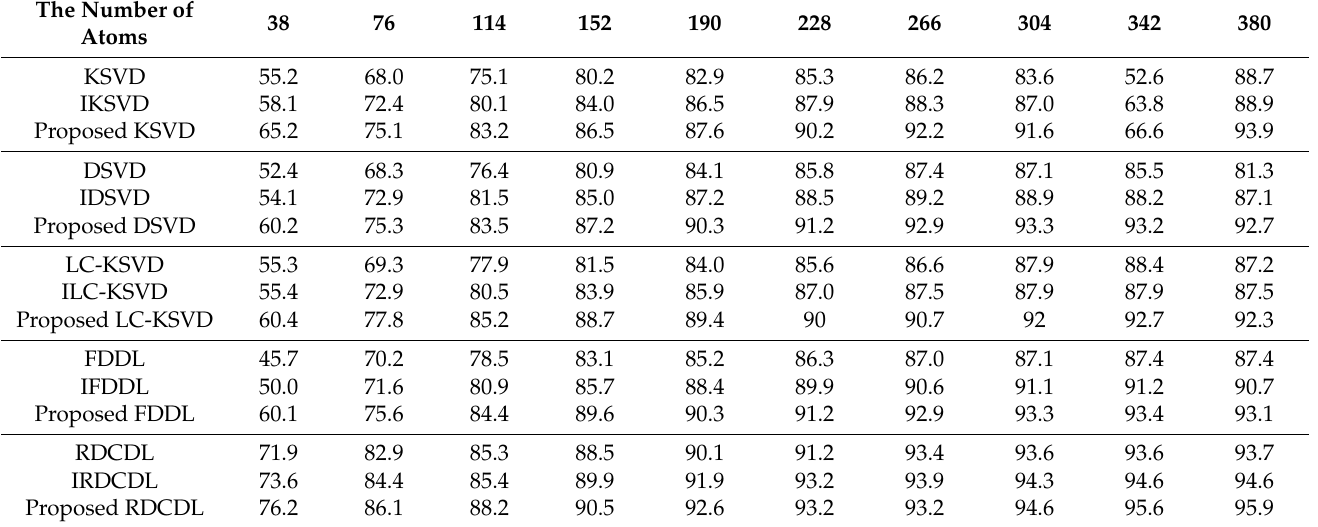
Table 1. Average accuracy (%) on the Yale B face database.